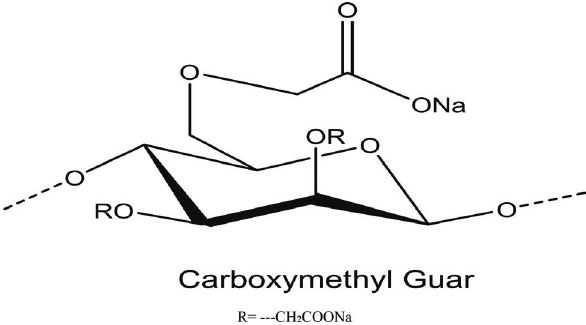
Figure 1: Structure of carboxymethyl guar